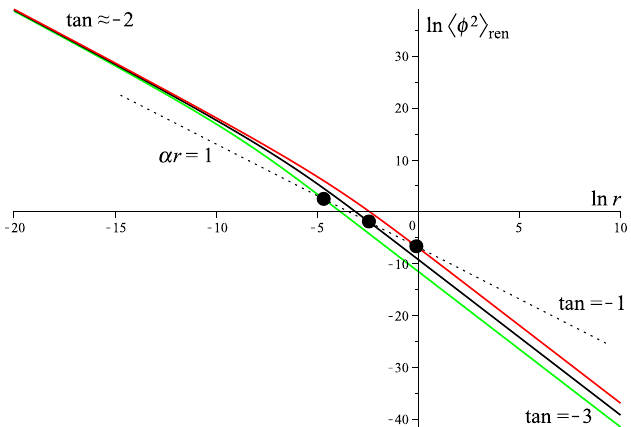
(cid:10) (cid:11) Figure 4. Plots of ln φ 2 versus ln r for α = 1 (red), α = 10 (black) and α = 100 (green). Dots on ren each curve correspond to the value r = α − 1 and distinguish two characteristic